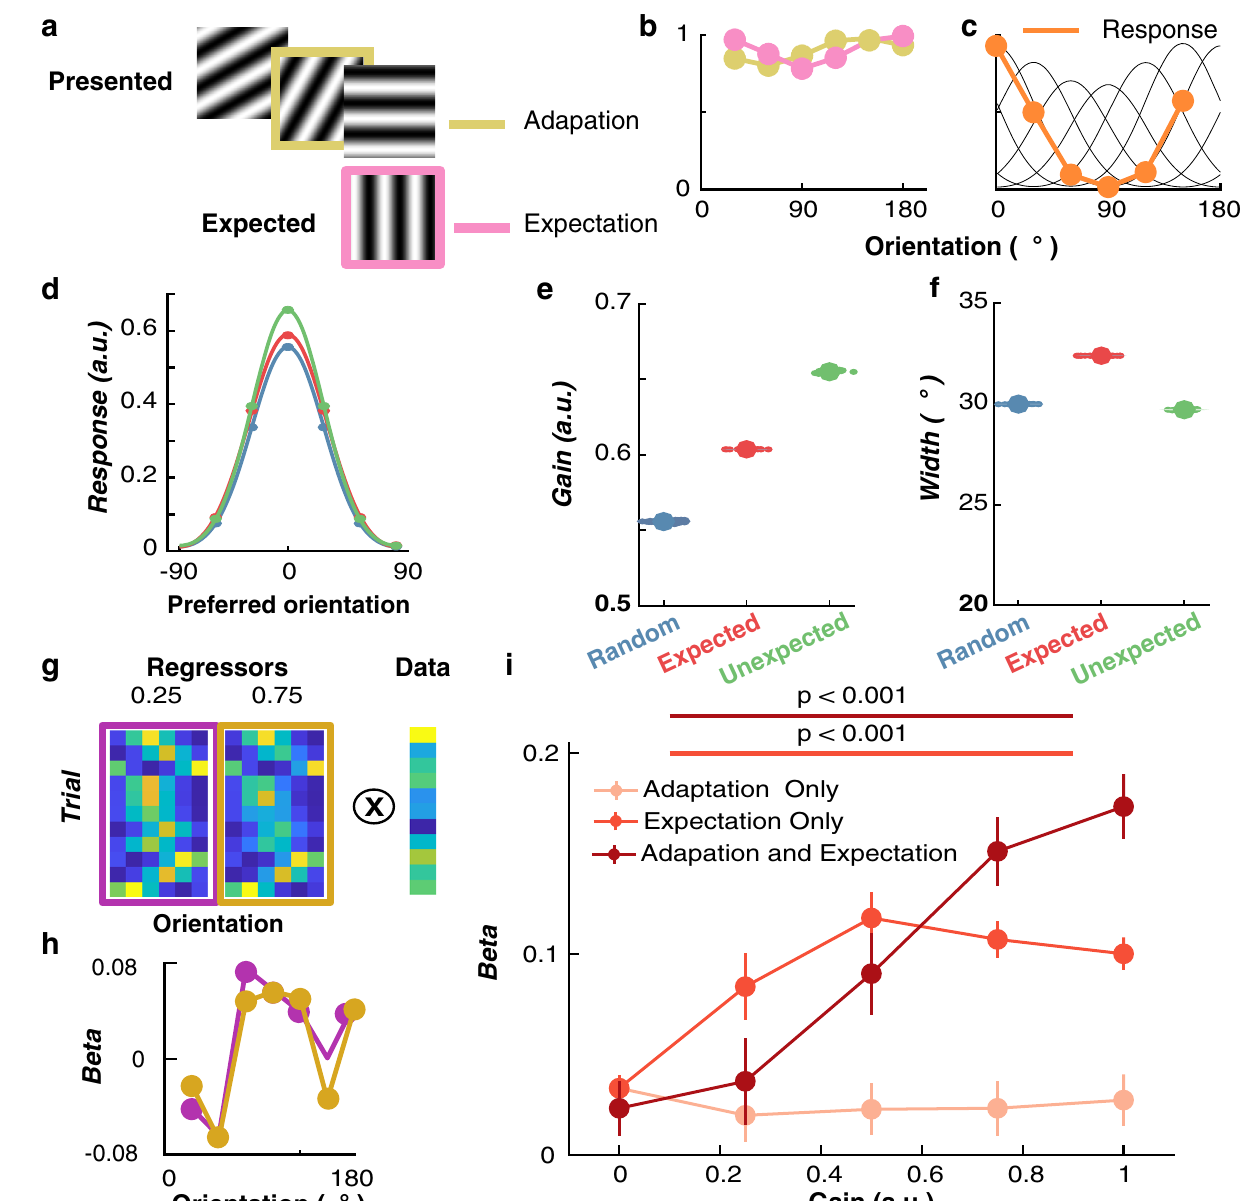
Fig. 5 | Computational model for explaining variance in neuronal response by incorporating gain modulation from prediction and adaptation effects. The model consists of a bank of six neurons maximally selective for different orienta- tions. The model ’ s sensitivity is affected by previous orientations in the sequence (Adaptation) as well as future predicted orientations (Expectation). These factors determine the response to the presented orientation on each trial. a An example sequence of trials in the rotating condition. The orientations of the preceding (mustard)andexpected(pink)trialsdeterminetheadaptationandtheexpectation gains. b The adaptation gain (mustard line) isdetermined by the orientationof the previousstimuli.Theexpectationgain(pinkline)isdeterminedbytheinversecopy of theresponse totheexpected orientation. c Collectively,thetwogainsmodulate the sensitivity of the channels on the next trial. These weights for the different orientationsareappliedtothemodel ’ ssensitivitychannels(blacklines),whichgive theresponse(orangeline)tothepresentedorientation(verticaldashedline;inthis case 0°). d Dots indicate the responses of the channels, and the curves are fi tted